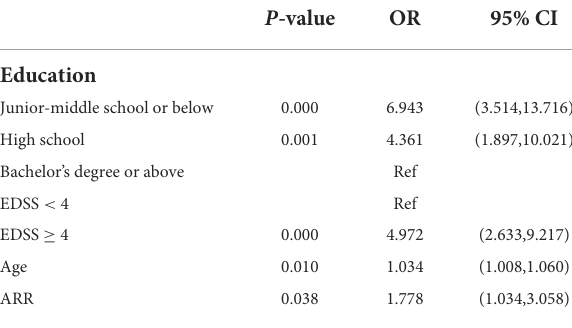
TABLE 2 Binary logistic regression analysis showing the influence factors of